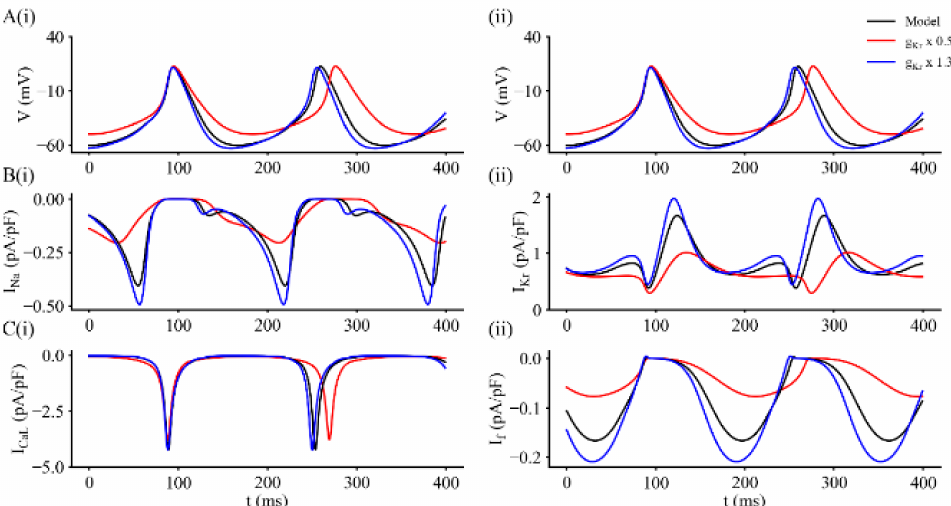
Figure 5. Illustration of simulated action potentials, pacemaker depolarizations and selected un- derlying ion channel-mediated currents obtained using the updated adult murine SAN myocyte model. In each panel the three superimposed traces represent control or baseline data (black), results obtained after the maximal conductance for I Kr was reduced by 50% (red), and data obtained after I Kr had been increased to 130% of its baseline value (blue). Panels A ( i ) and A ( ii ) are duplicates; each trace illustrates two action potentials and pacemaker depolarizations. Panel B ( i ) shows Na + current, and I Kr records are shown in B ( ii ). Panel C ( i ) illustrates I CaL traces; and Panel C ( ii ) shows changes in the hyperpolarization-activated current, I f . Note that when I kr is decreased, the pacemaker rate slows; and the opposite occurs when I Kr is increased. Changes in I Kr also significantly change the maximum diastolic potential (MDP). This effect produces secondary changes in I Na , I CaL and I f , which in combination, modulates SAN pacemaker